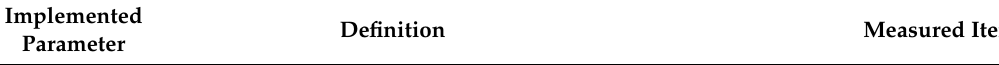
Table 6. The three implementing parameters and their item